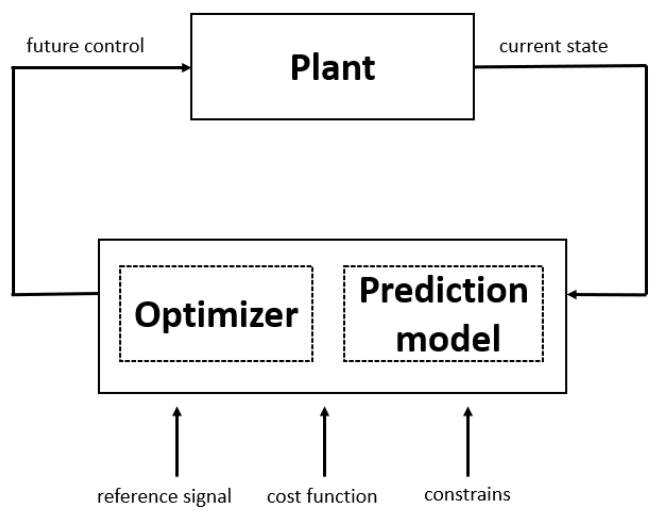
Figure 4. MPC Figure 4. MPC schema.